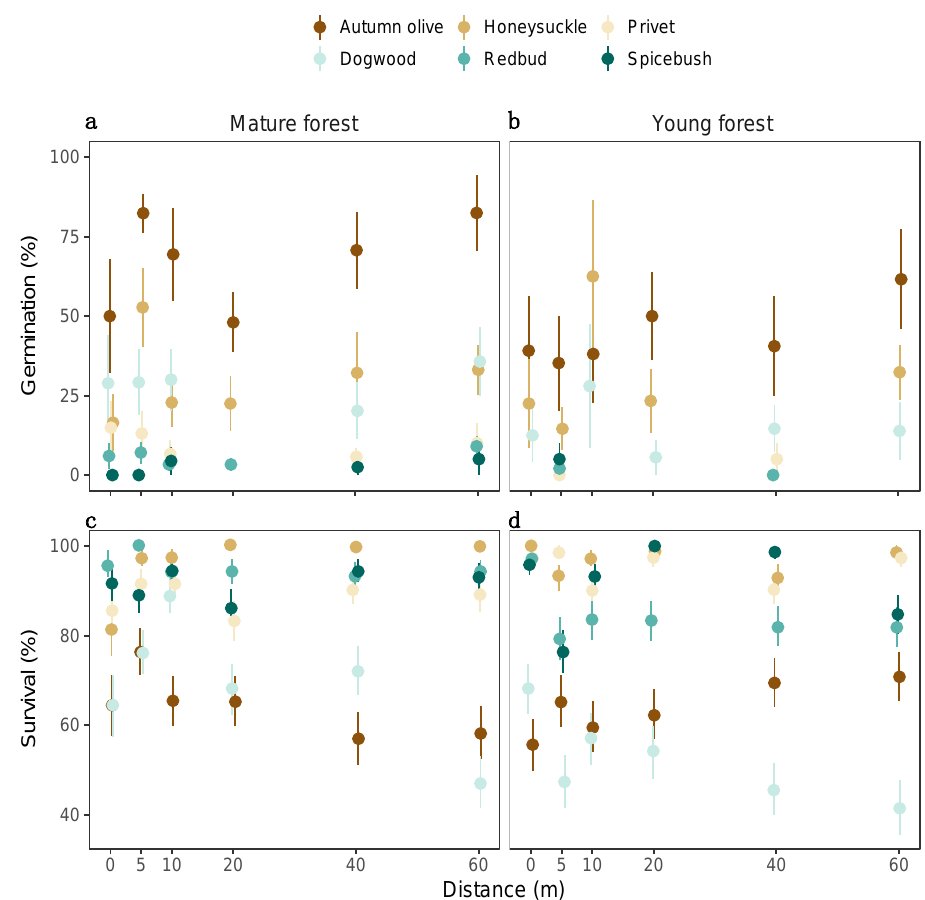
Figure 2. The mean and standard error of the observed seed germination and seedling survival of each species in ( a,c ) mature or ( b,d ) young forests at each distance from the forest edge. The brown shading indicates the group of invasive species while the blue shading indicates the group of native species. Points are slightly jittered to reduce overlap at each distance.